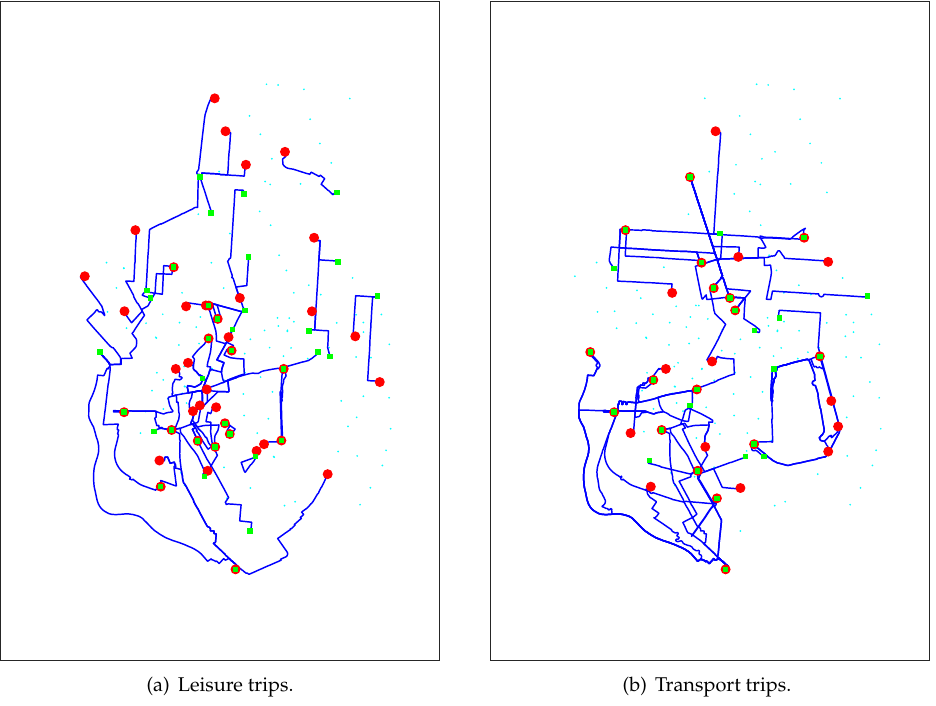
Figure 5. Main leisure and transport trajectories.